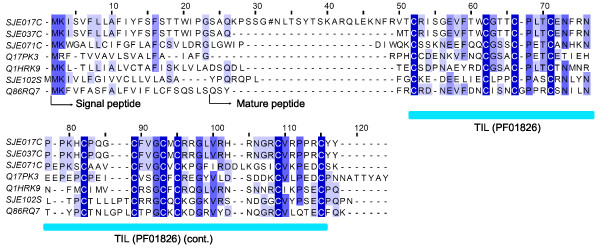
Sequence alignment of trypsin inhibitor like (TIL) peptides. SJEs are clusters from this work. The others are Q17PK3 (Cysteine-rich venom protein, Aedes aegypti), Q1HRK9 (TIL domain-containing cysteine-rich salivary secreted peptide, Aedes aegypti), and Q86RQ7 (Venom peptide BmKAPi, Mesobuthus martensii).